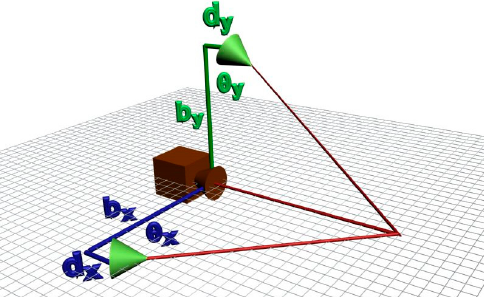
Figure 8. Geometric parameters of the digitization system.